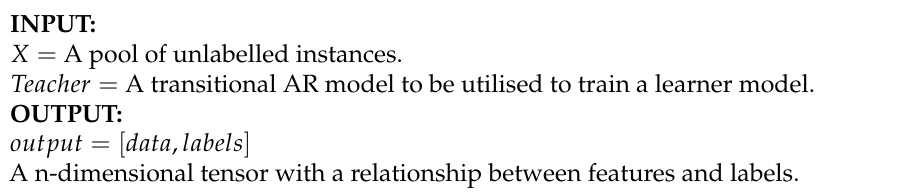
Algorithm 5 Construction of AR models based on the data and labels given by a